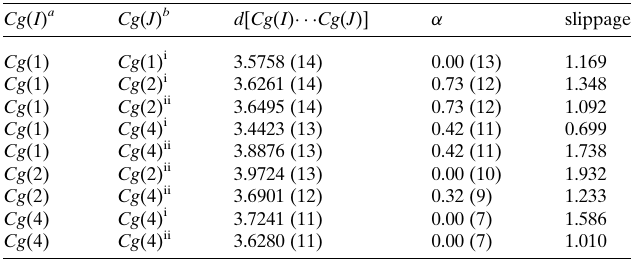
Table 2 (cid:2) – (cid:2) distances (A˚ ) and angles ( (cid:2) ) for the title compound. Cg ( I )— Cg ( J ) is the distance between ring centroids, (cid:4) is dihedral angle between planes Cg ( I ) and Cg ( J ) and slippage is the distance between Cg ( I ) and perpendicular the projection of Cg ( J ) on ring I. Cg (1), Cg (2) and Cg (4) are the centroids N2/C3–C6, N1/C1/C2/C3/N2/C7 and C1–C7/N1/N2 rings, respectively.